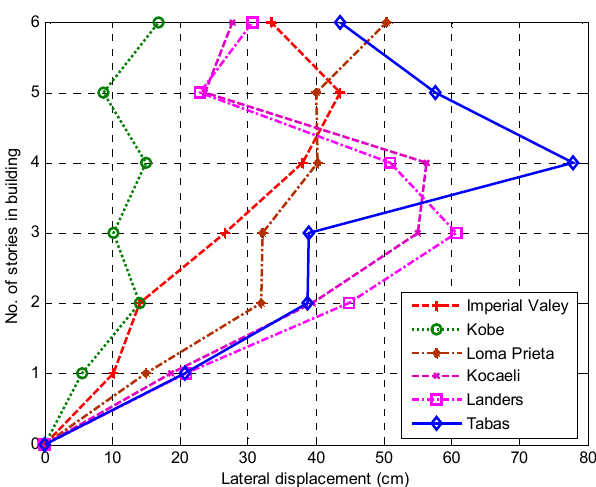
Figure 3. Peak lateral displacements of buildings under different earthquake records.